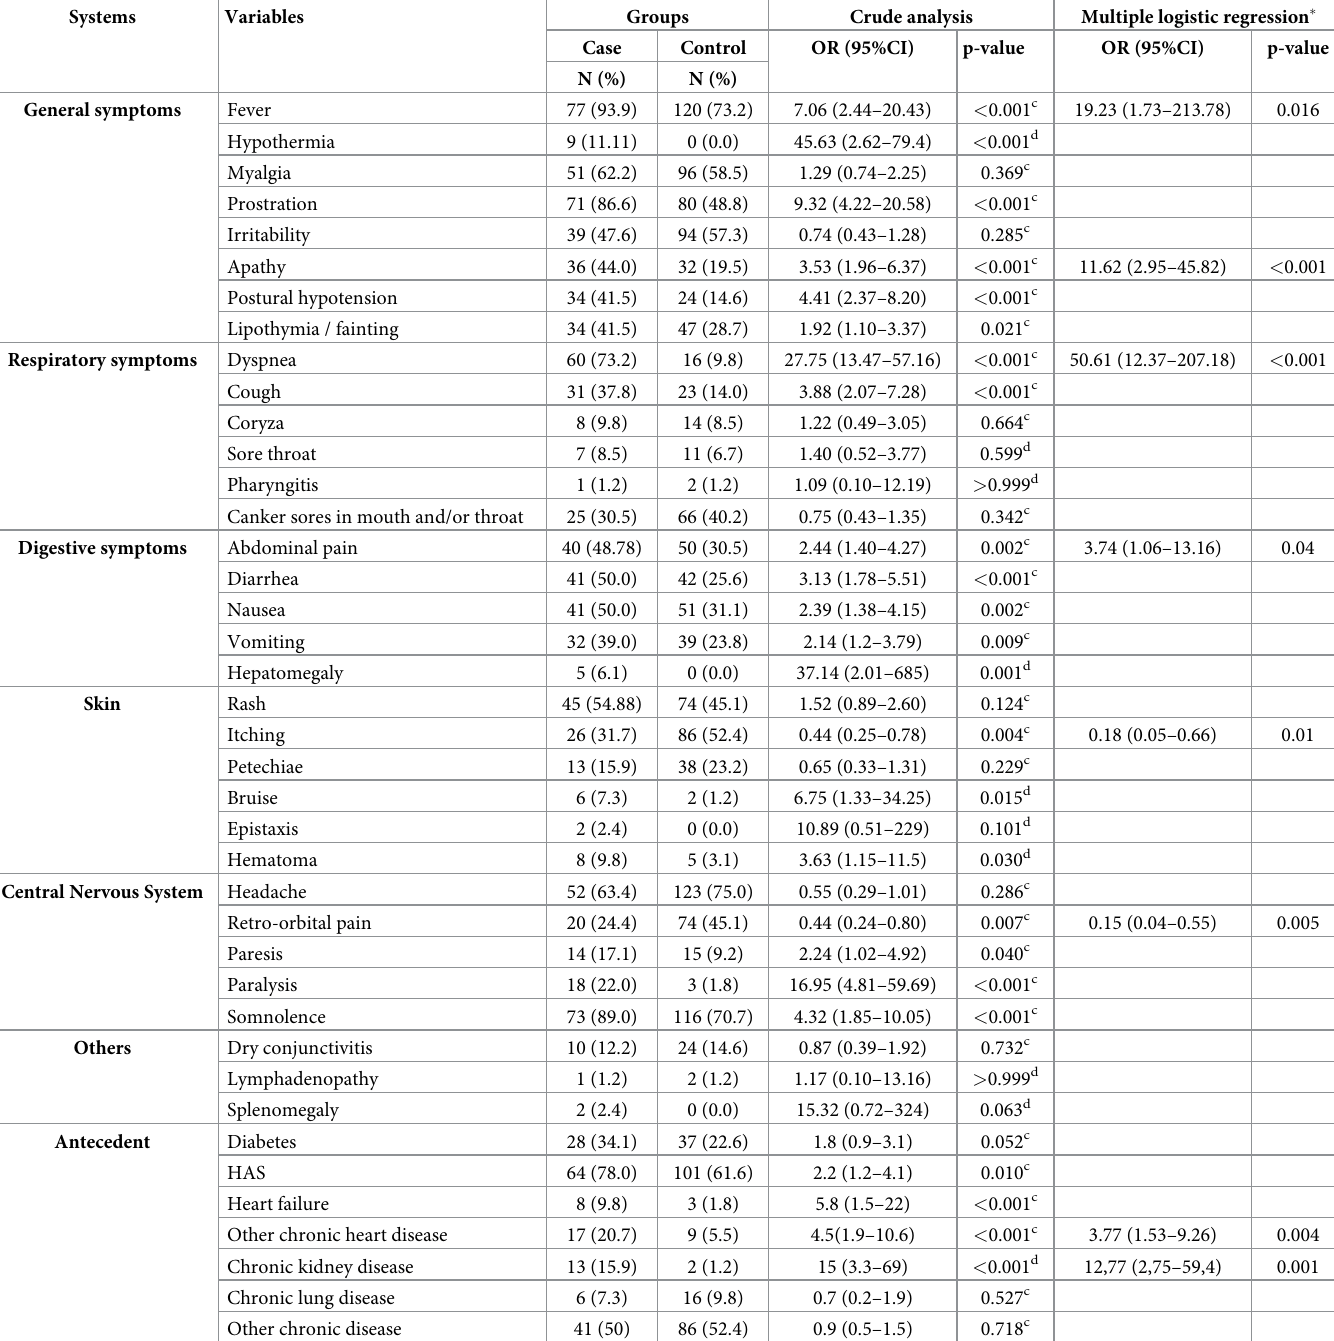
Table 2. Frequency of signs and symptoms of several systems and likelihood of death from Chikungunya. Fortaleza (Brazil), 2017.